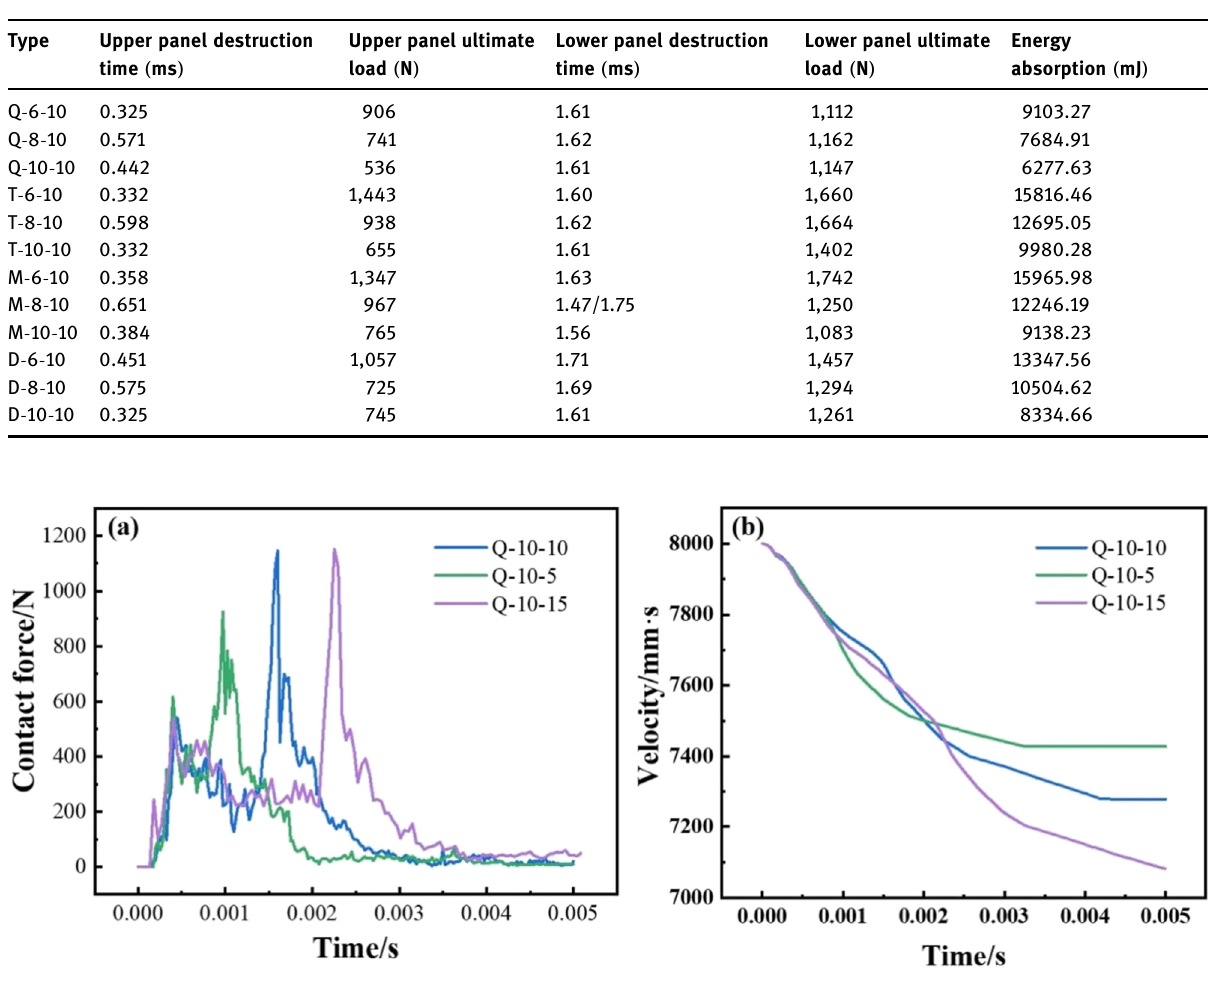
Figure 8: Comparison between contact force – time and velocity – time curves of Q - 10 - 5, Q - 10 - 10, and Q - 10 - 15. ( a ) Contact force – time curves and ( b ) velocity – time